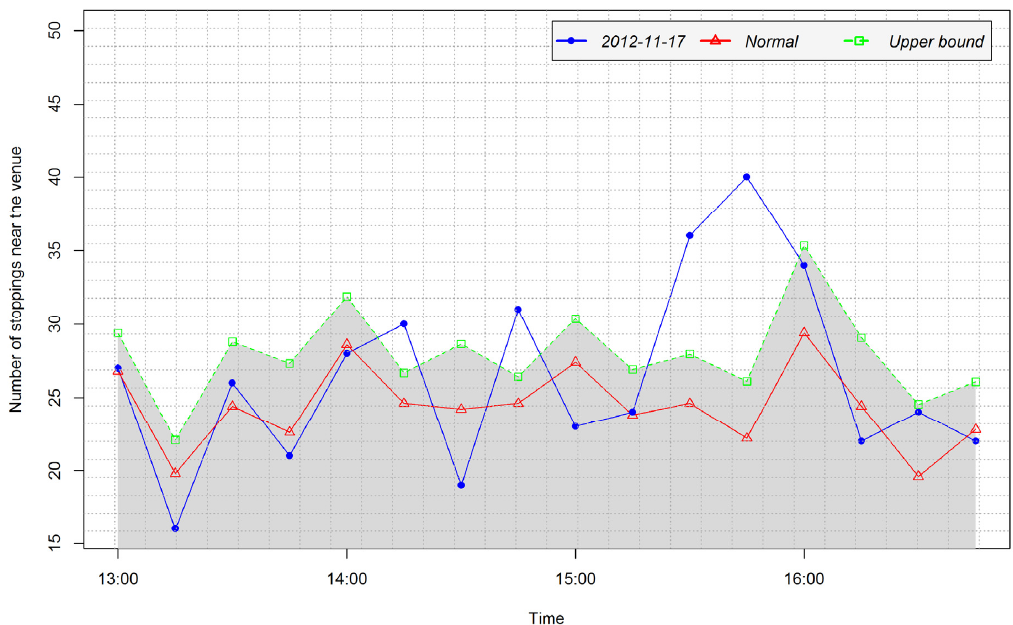
Figure 14. The variation of the number of bus stoppings at the National Concert hall during the period around the arrival time of event attendees.